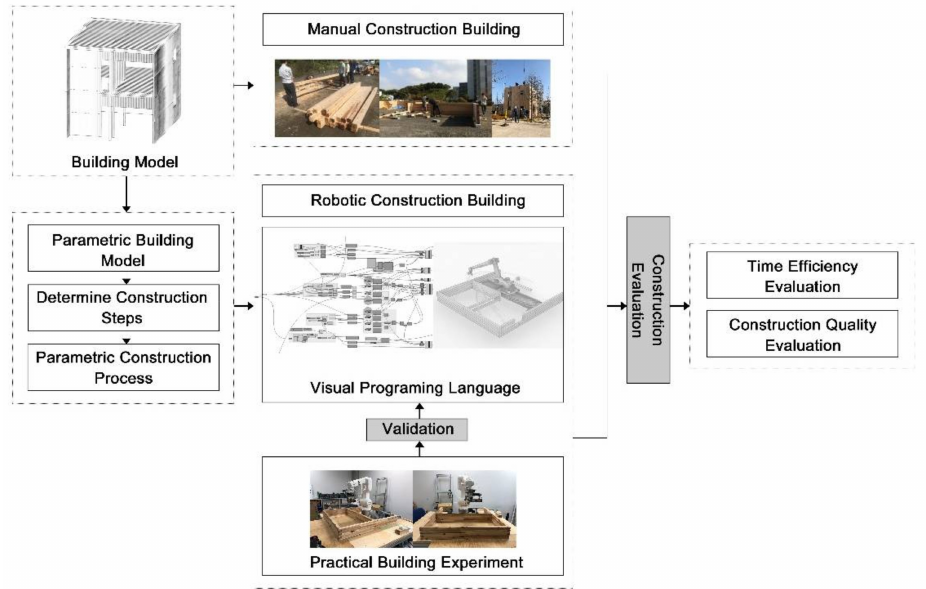
Figure 1. A graphic abstract for robotic construction of the wooden